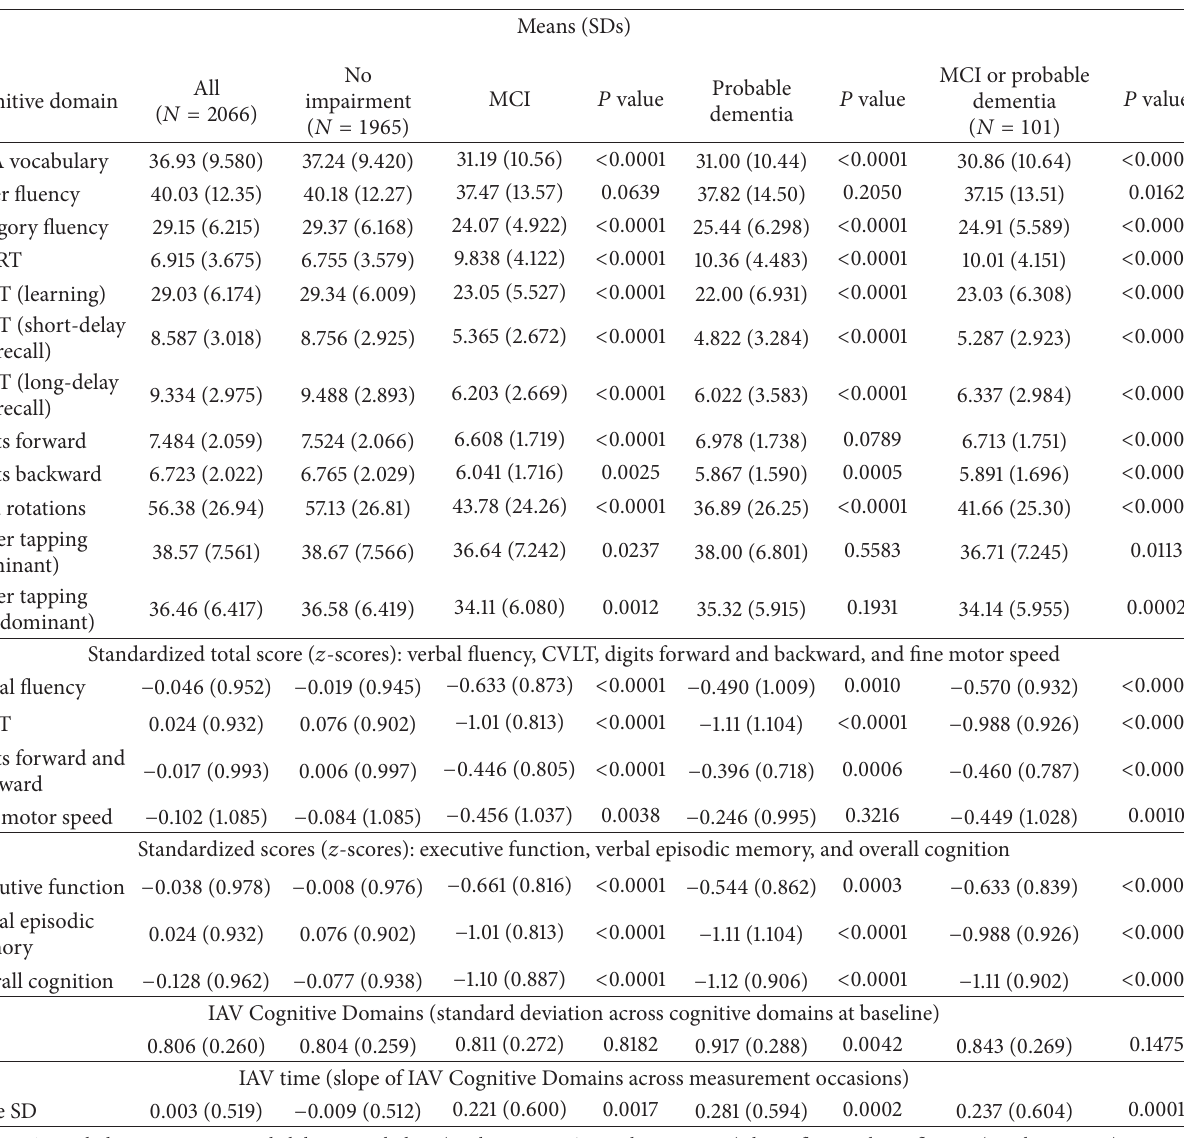
Table 1: Means (SDs) of the raw and standardized scores for the cognitive measures at baseline, standardized scores for executive function, verbal episodic memory, overall cognition, IAV Cognitive Domains, and IAV Time for WHISCA participants by group.